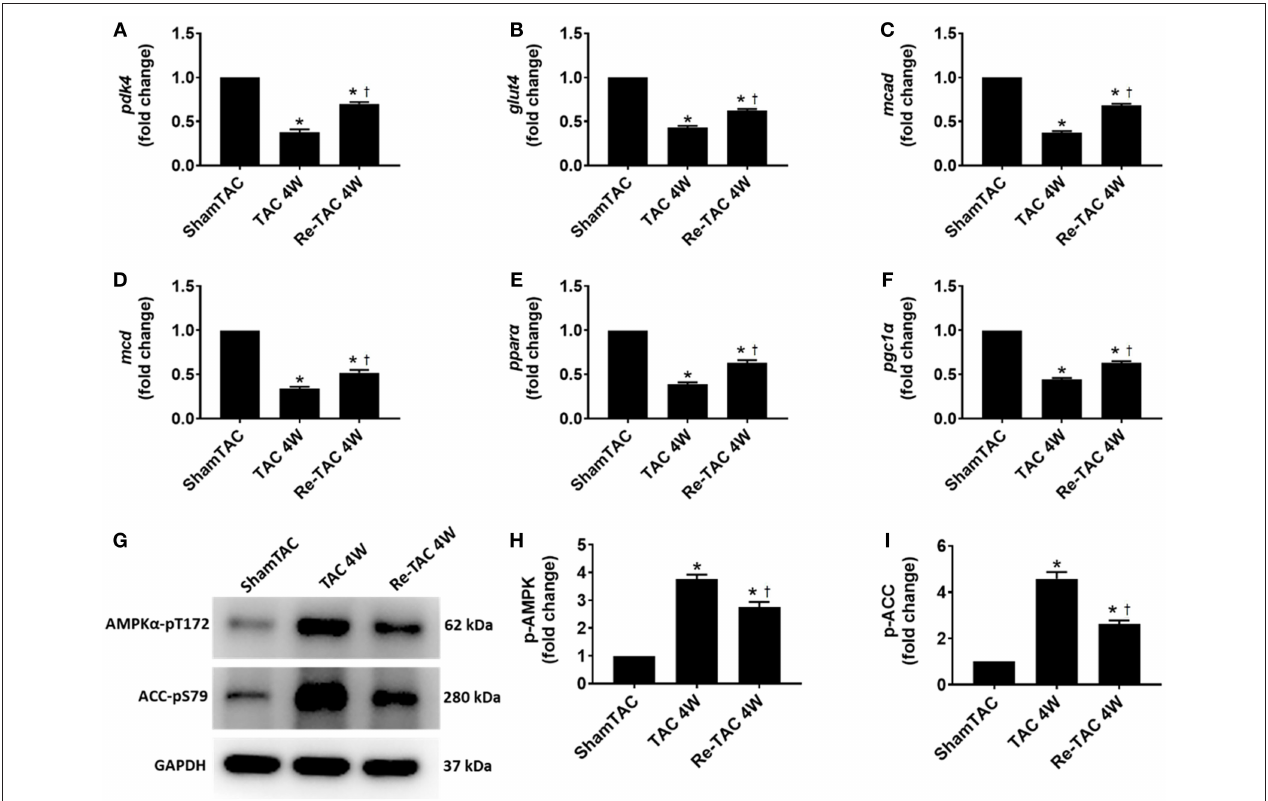
FIGURE 2 | Hypertrophic preconditioning improves substrate utilization in pressure overload hearts. Real-time quantitative PCR analyses for the gene expression of (A) pyruvate dehydrogenase kinase 4 ( pdk4 ), (B) glucose transporter type 4 ( glut4 ), (C) medium-chain acyl-CoA dehydrogenase (mcad), (D) malonyl-CoA decarboxylase ( mcd ), (E) peroxisome proliferator-activated receptor α ( ppar α ), and (F) peroxisome proliferator-activated receptor gamma coactivator 1 α ( pgc1 α ). Representative images (G) and densitometric assessment (H,I) of cardiac phosphorylated AMP-activated protein kinase (p-AMPK) and phosphorylated acetyl-CoA carboxylase (p-ACC) as acquired by Western blot analysis. * P < 0.05 vs. Sham TAC; † P < 0.05 vs. TAC